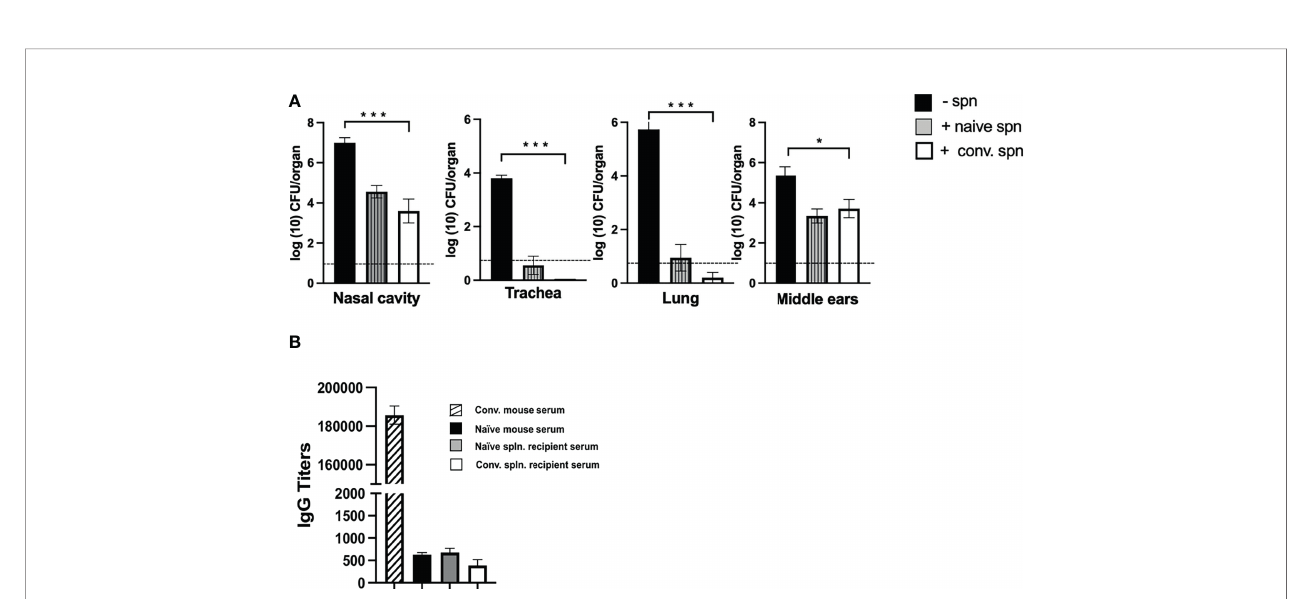
FIGURE 5 | Effect of splenocyte transfer on the growth of B . bronchiseptica in Rag-1 − / − mice. (A) Graphs represent the number of CFUs of B . bronchiseptica recovered at day 28 post-inoculation from the respiratory tract and middle ears of Rag-1 − / − mice that either received no splenocytes (black) or mice that received splenocytes from naive mice (dark gray striped column) or splenocytes from convalescent mice (white column) 2 h before being inoculated with 500 CFUs of bacteria ( n = 4 mice per group). Error bars represent the standard deviation. Dotted line represents the limit of detection. (B) Graphs represent the anti- B. bronchiseptica serum IgG titers (arbitrary units) from mice studied in (A) [control serum from d56 p.i. convalescent mice (striped column); no splenocytes (black); splenocytes from naive mice (dark gray), convalescent splenocytes (white)]. Error bars: ± SEM; * p < 0.05, ***